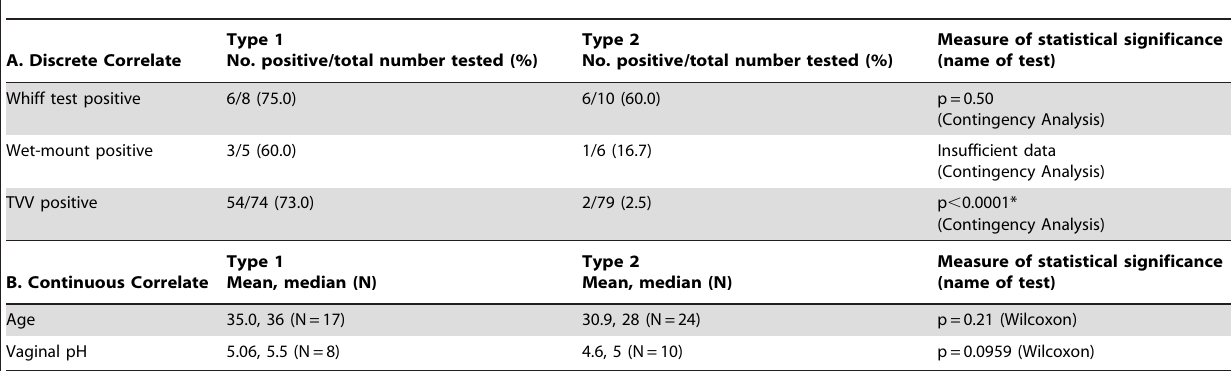
Table 3. Correlations between T. vaginalis types and clinical